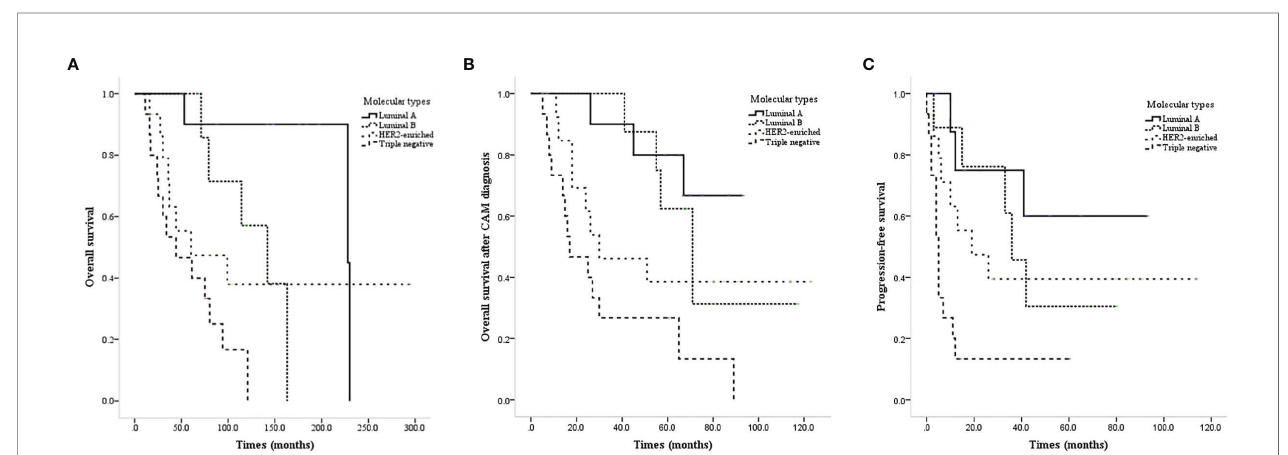
FIGURE 1 | Survival curves of CAM patients based on different molecular types at the initial diagnosis. (A) OS of CAM patients based on different molecular types at the initial diagnosis. (B) CAM-OS of CAM patients based on different molecular types at the initial diagnosis. (C) PFS of CAM patients based on different molecular types at the initial